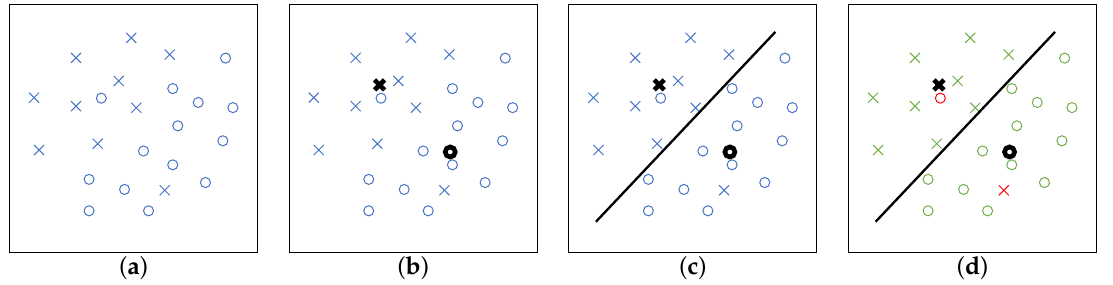
Figure 5. Principle of calculation of the Fog Classification Coefficient (FCC). ( a ) Two type of fogs representation. ( b ) Average. ( c ) Classification. ( d ) Correct and wrong